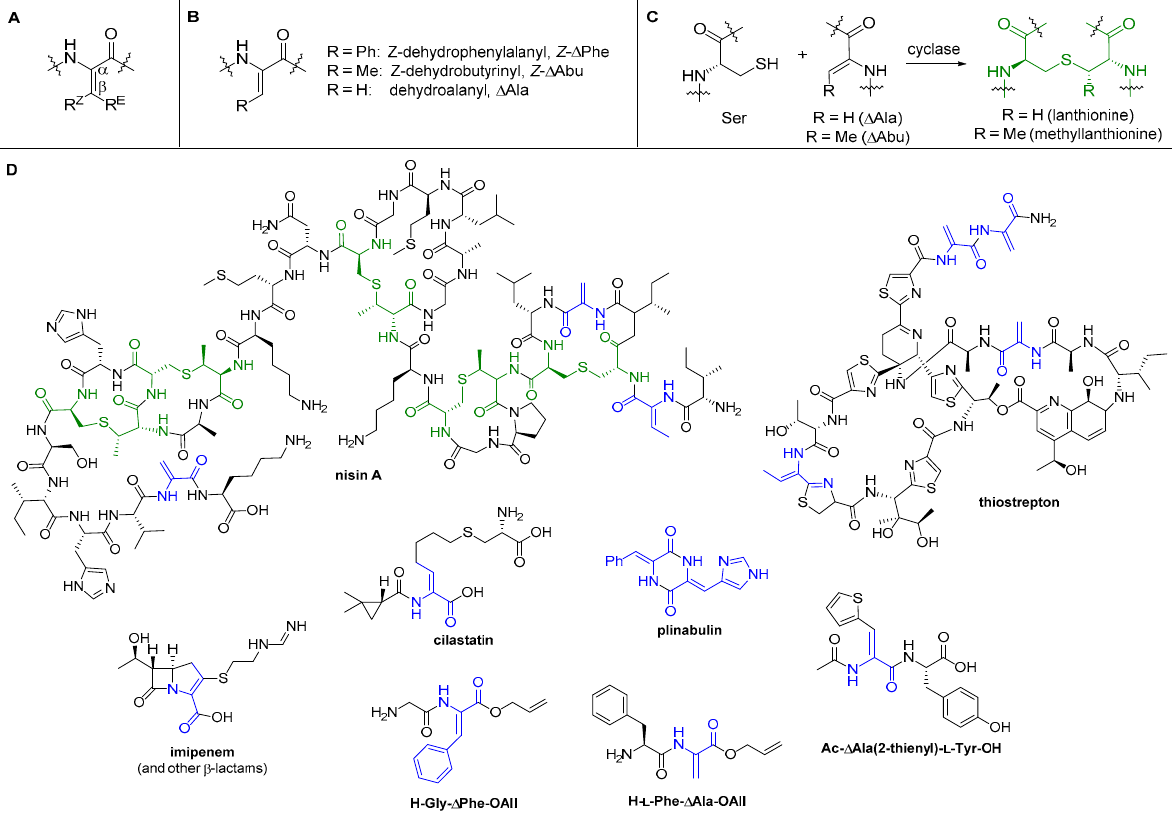
Figure 2. ( A ) General structure of dehydroamino acid residue. ( B ) Important dehydroamino acid residues relevant to supramolecular hydrogels and nanostructures. ( C ) Lanthionine residues are formed through an intramolecular reaction involving serine and dehydroalanine, in the biosynthesis of lantibiotic peptides. ( D ) Examples of biologically active dehy- dropeptides.